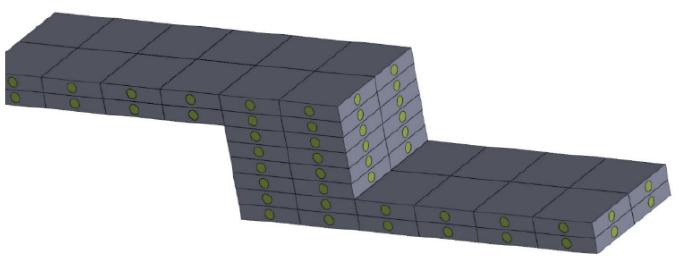
Figure 5. Model of a lever with a modular structure of studied cell structures.